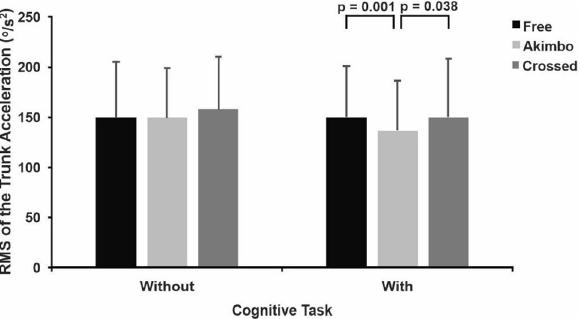
Figure 4. Mean and standard deviation of the interaction between cognitive task and arm position for the RMS of the trunk acceleration. The horizontal lines indicate pairwise differences with the respective p